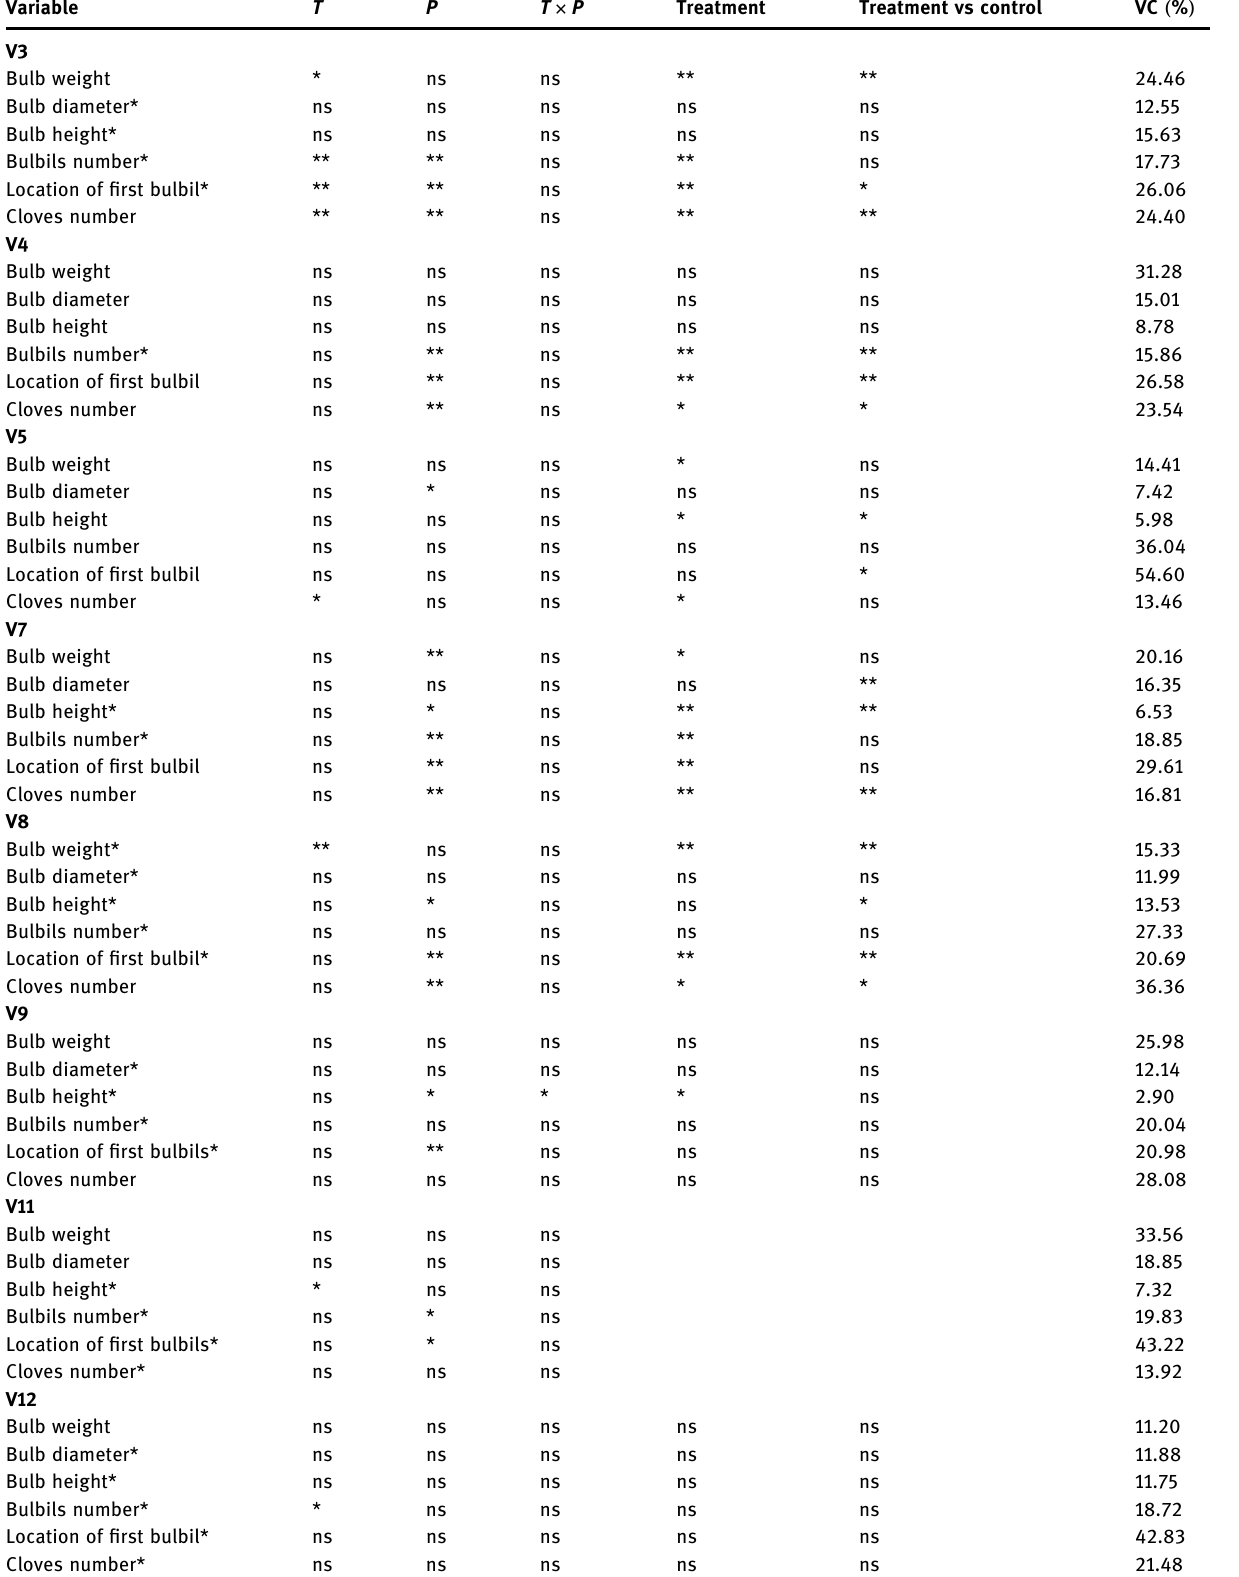
Table 4: Recapitulation variants analysis characters of garlic